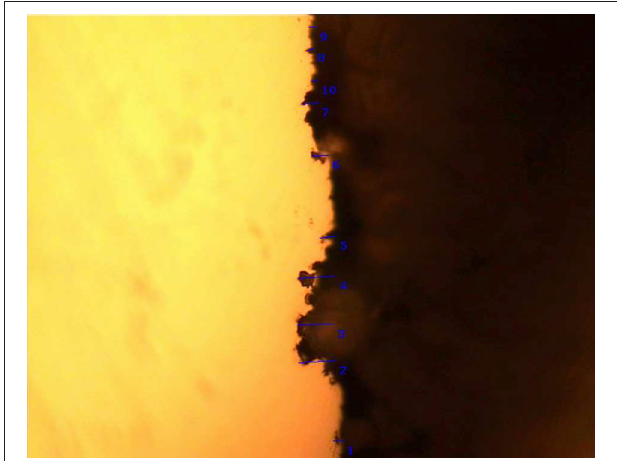
FIGURE 2 | x500 magnification photo and measures of pit depth in pre-corroded bars.